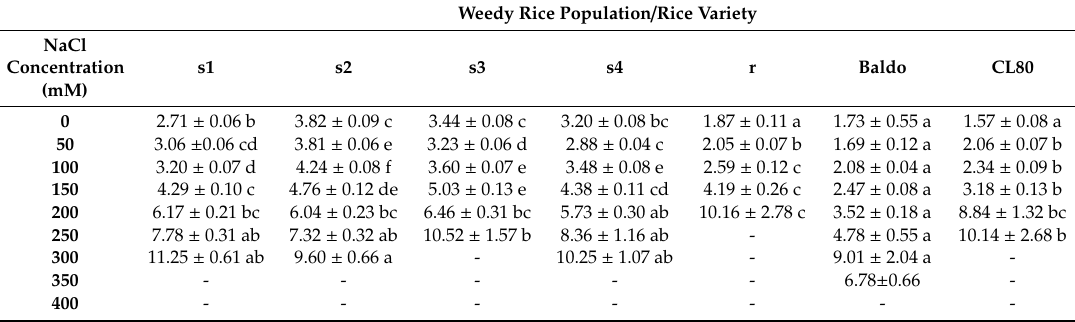
Table 3. Time (days) required to reach 50% seed germination (T 50 ± SE) of the tested weedy rice populations and rice varieties at each NaCl concentration. Comparisons were made among rice varieties and weedy rice populations, separately for each NaCl concentration (among values on the same row). Values sharing the same letters are not significantly di ff erent according to the LSD test with Bonferroni adjustment ( α ≤